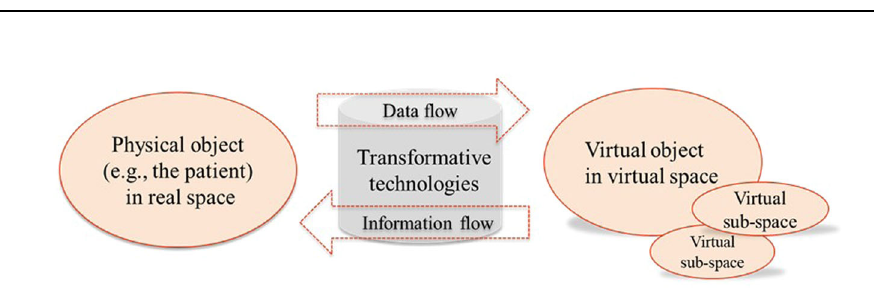
Fig. 2 Concept of a cyber-physical-system, enabled by the convergence and synchronisation of physical and virtual systems 8